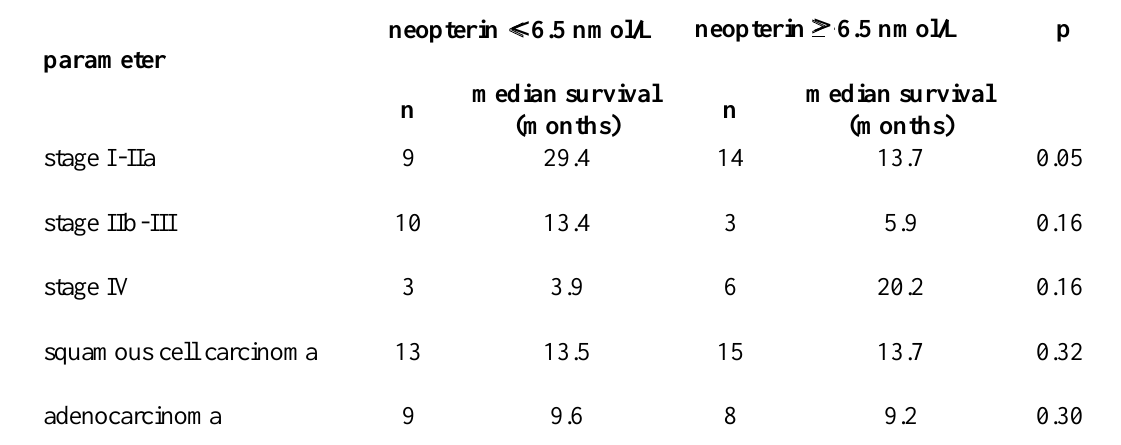
Table 1. Survival according serum neopterin concentrations in different subgroups of patients